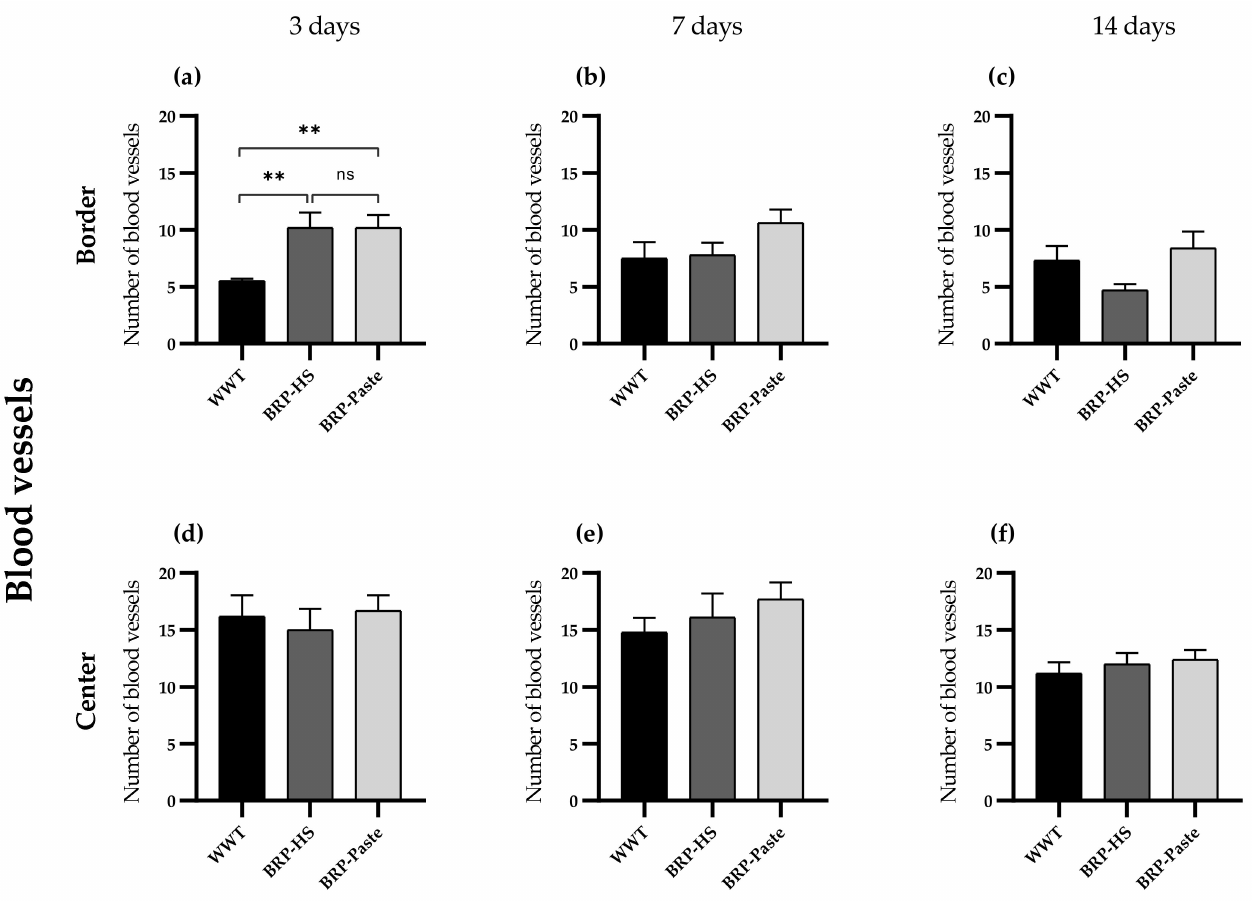
Figure 12. Number of blood vessels in the border ( a – c ) and center ( d – f ) of the wounds (dermis) in groups WWT, HS, BRP-HS, Paste and BRP-Paste after 3 ( a , d ), 7 ( b , e ) and 14 ( c , f ) days of treatment. Statistical difference according the Kruskall-Wallis test followed by Dunn’s posttest ( n = 6) in which ** p < 0.01. ns = no